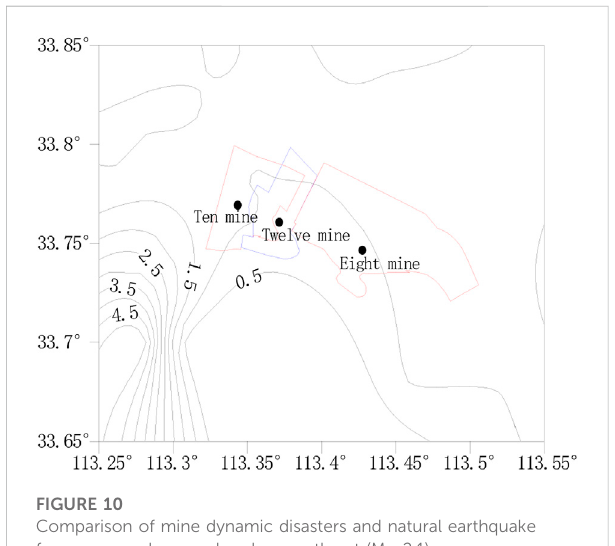
FIGURE 10 Comparison of mine dynamic disasters and natural earthquake frequency such as coal and gas outburst (M S > 2.1).